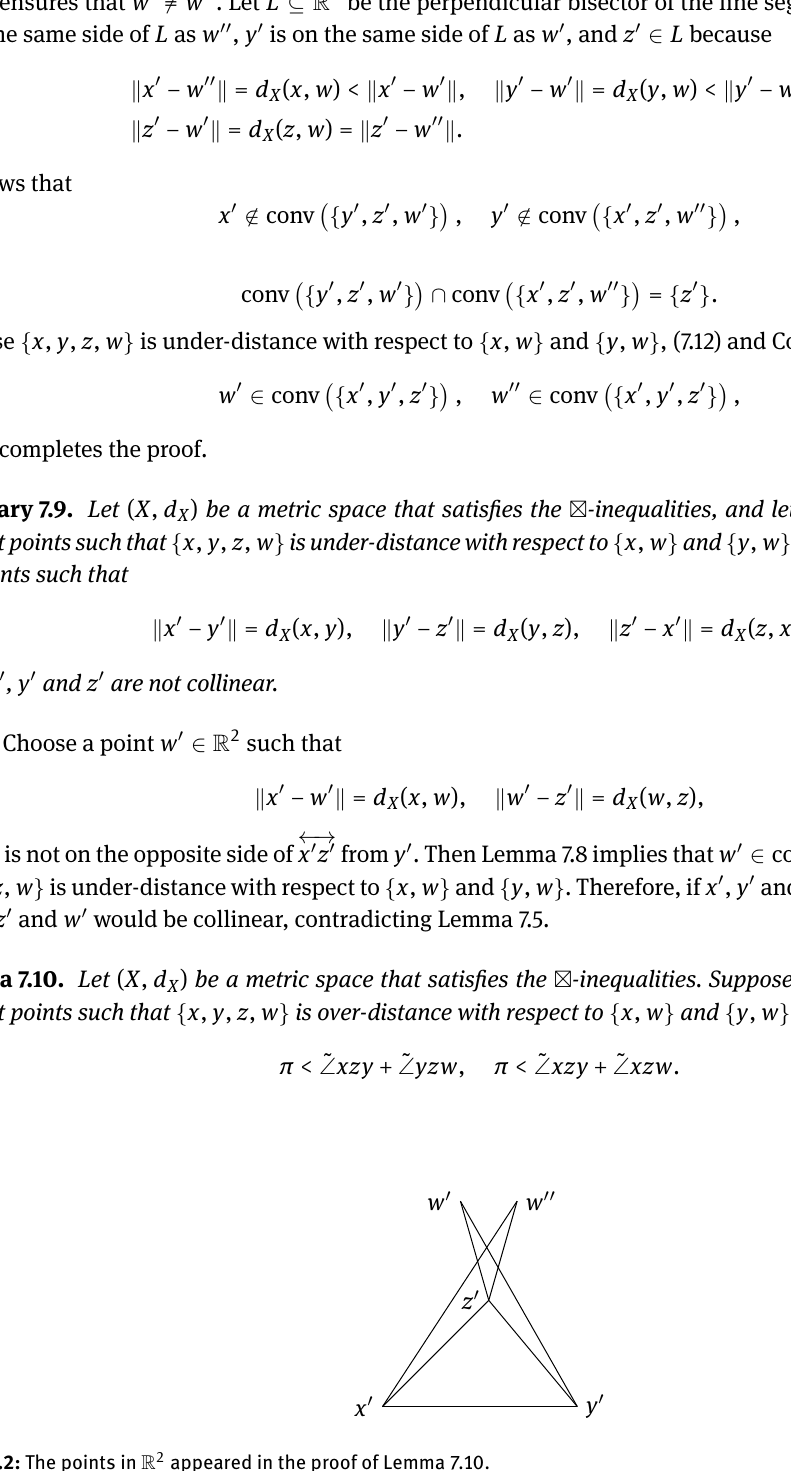
Figure 7.2: The points in R 2 appeared in the proof of Lemma